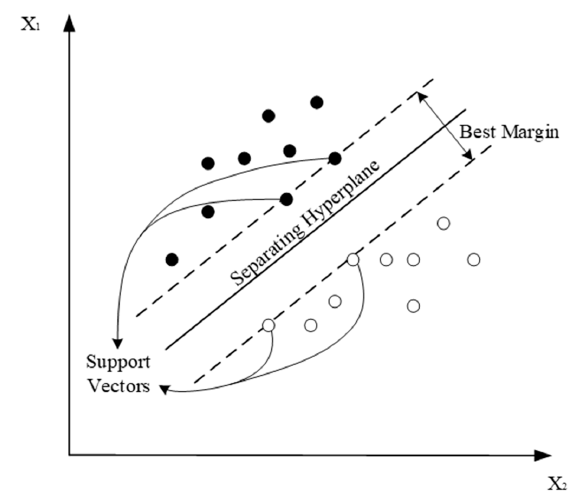
Figure 3. Working principle of support vector machine.